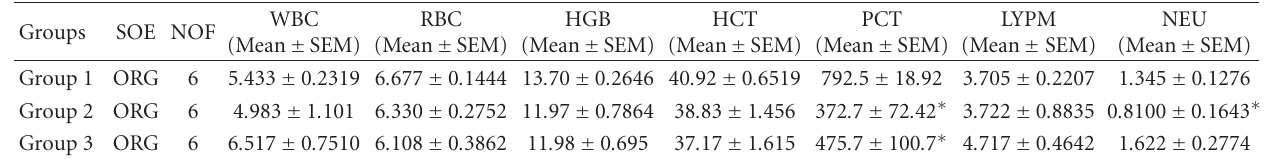
Table 4: Hematological Profile of Rats at first